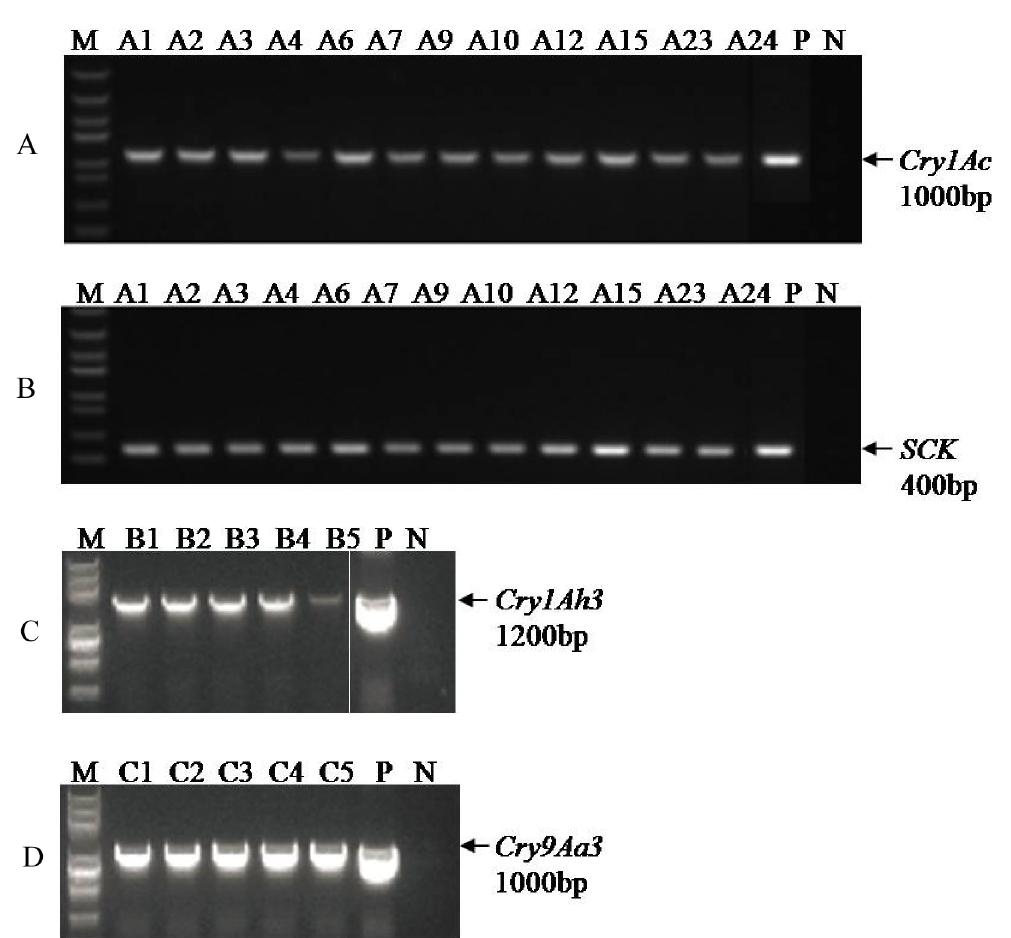
Fig 2. PCR detection of transgenic poplar. (A) and (B) PCR analysisfor the presenceof the Cry1Ac and SCK gene in transgenic plants. (C) PCR analysisfor the presenceof the Cry1Ah3 gene in transgenic plants. (D) PCR analysisfor the presenceof the Cry9Aa3 gene in transgenic plants. M: DNA fragments size marker (Trans5K); P: plasmid(positivecontrol); N: wild type plants (negative control). The arrows indicatethe expectedPCR products. genes, respectively. Different transgenic lines had variable levels of target protein expression (Fig 3). Within the same transgenic line series, the target Bt protein expression levels is approx- imately consistent with the transcription abundance detected by qualitative PCR in exact lines.